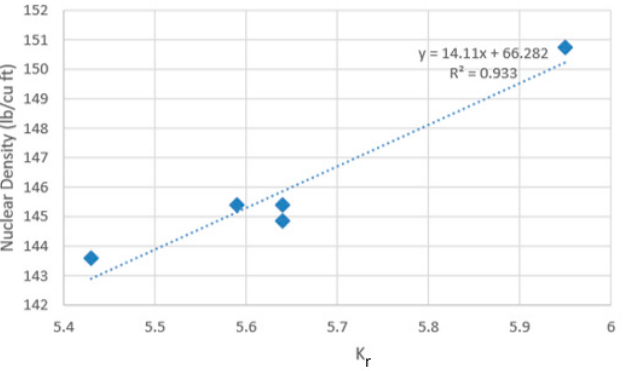
Figure 4. Correlation between nuclear density and PDP k r data [14]. A linear model is fitted to the data.